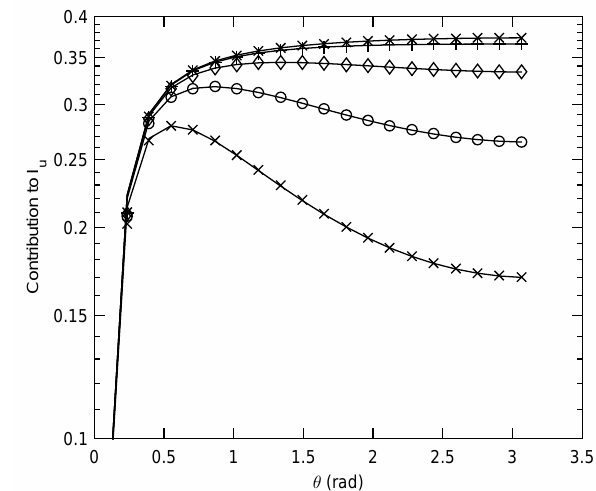
Figure 6. Variation in relative error with θ 0 for s = 0 . 1. N s = 20, + ; N s = 40, ◦ ; N s = 80, × ; N s = 160, (cid:63) .